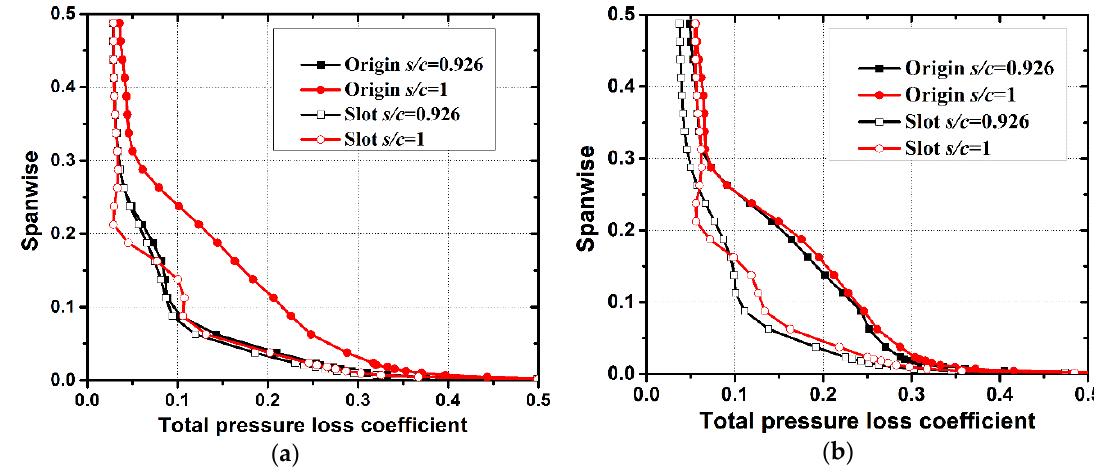
Figure 6. Influence of pitch-chord ratio on the spanwise profile of the total pressure loss coefficient: ( a ) i = 0 ° ; and ( b ) i = 3 ° .